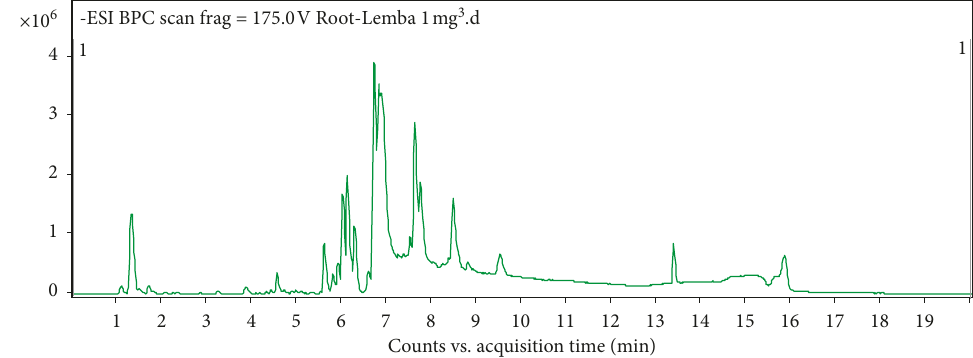
Figure 3: LC-MS chromatogram screening of the C. latifolia root extract. Table 3: LC-MS analysis of Curculigo latifolia root